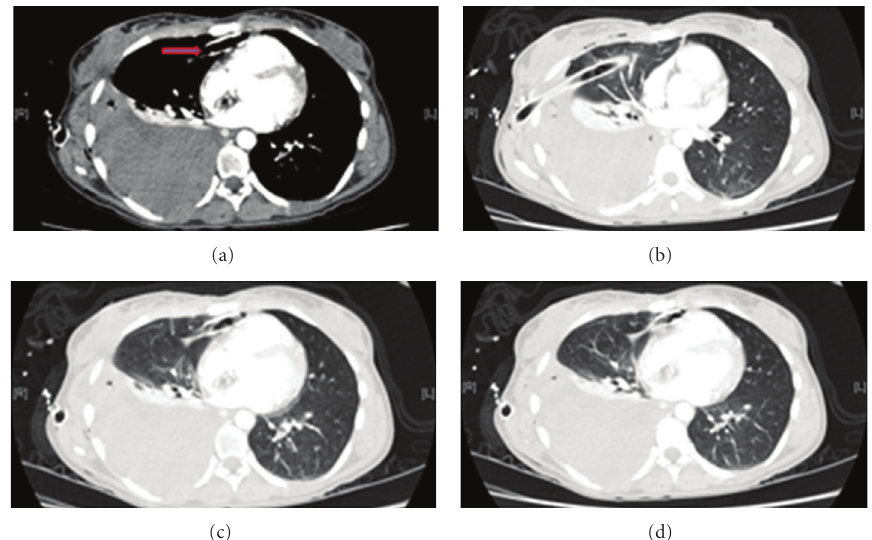
Figure 22: Axial CT scans on the same patient as in Figure 22 showing inappropriately placed chest drain in an attempt to drain a right basal pleural e ff usion.